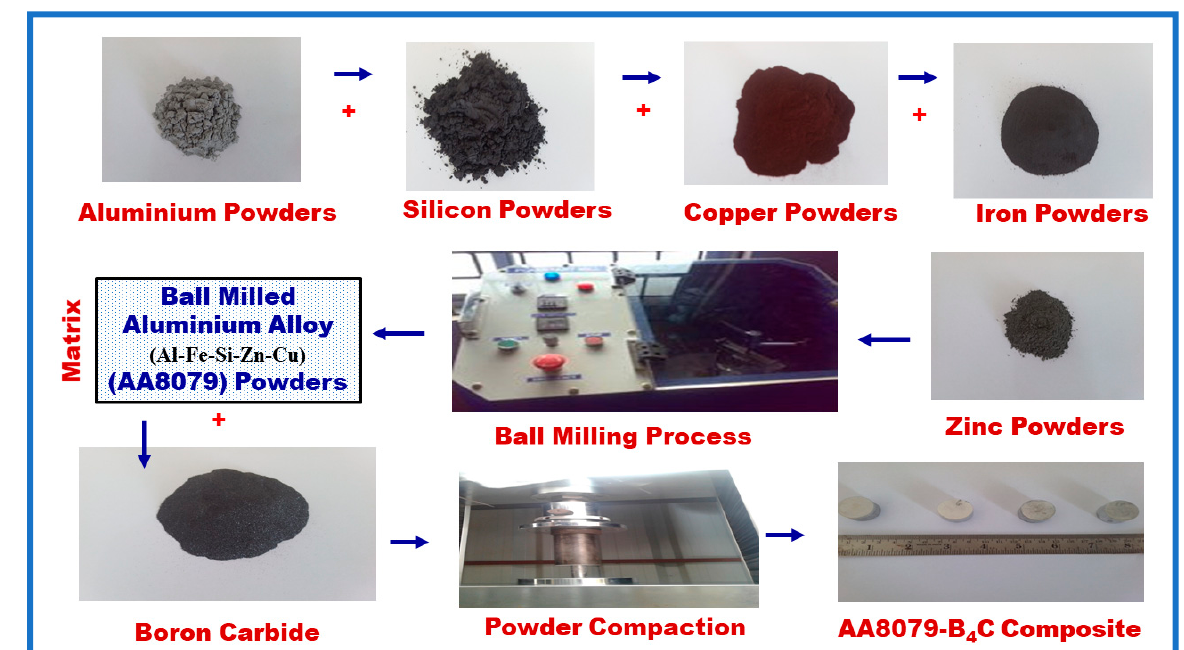
Figure 2. Synthesis of AA8079 and composite samples using ball milling and compaction method.